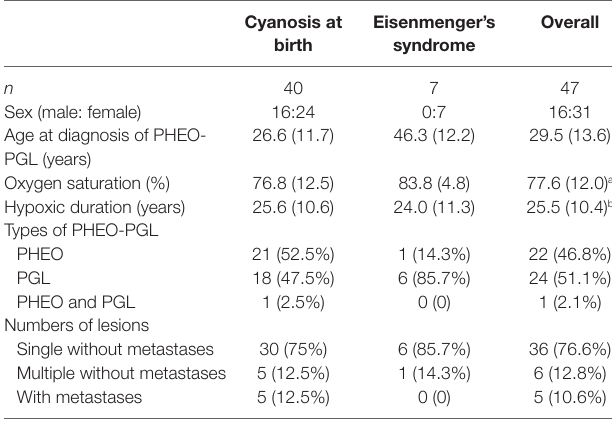
taBLe 1 | Summary characteristics of pheochromocytoma and paraganglioma (PHEO-PGL) patients with cyanotic congenital heart disease.